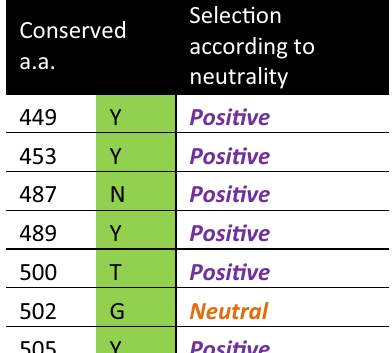
Table 1. Conserved residues involved in protein–protein interaction with ACE2 among the ACE2 binding spikes. The selection type according to the neutrality test are indicated.